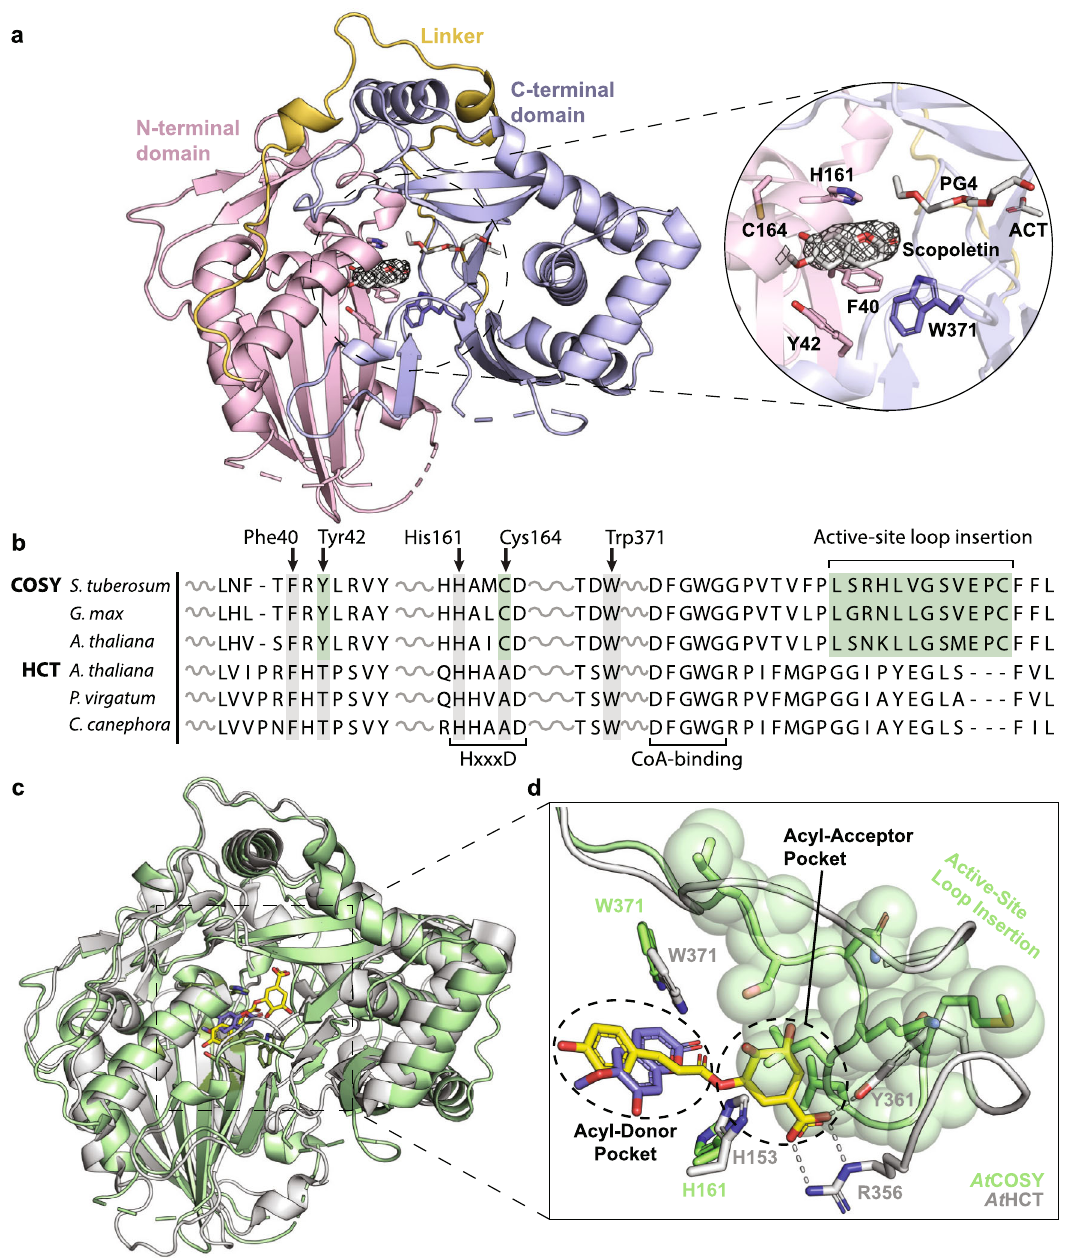
Fig. 1 | Structural and sequence characterization of COSY in comparison with HCT. a Scopoletin-bound At COSY at 2.5Å resolution. The overall fold showcases a pseudo-symmetric N-terminal (residues 1 – 181; light pink) and C-terminal (residues 230 – 451; light blue) domains, connected by a linker loop (residues 182 – 229; yel- low). The conserved BAHD catalytic residues (His161 and Trp371), along with pro- duct stabilizing residues (Phe40, Tyr42, and Cys164) are showcased within the active site pocket. Tetraethylene glycol (PG4) and acetate ion (ACT) are displayed. The mFo – DFc simulated annealing omit map with electron density map around